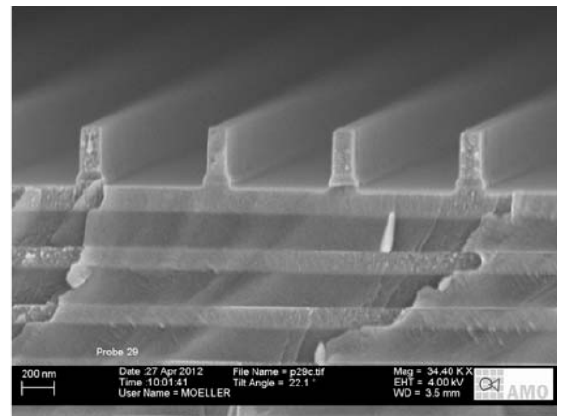
Figure 14. SEM image of the grating structure on a cleavage ‐ test sample.